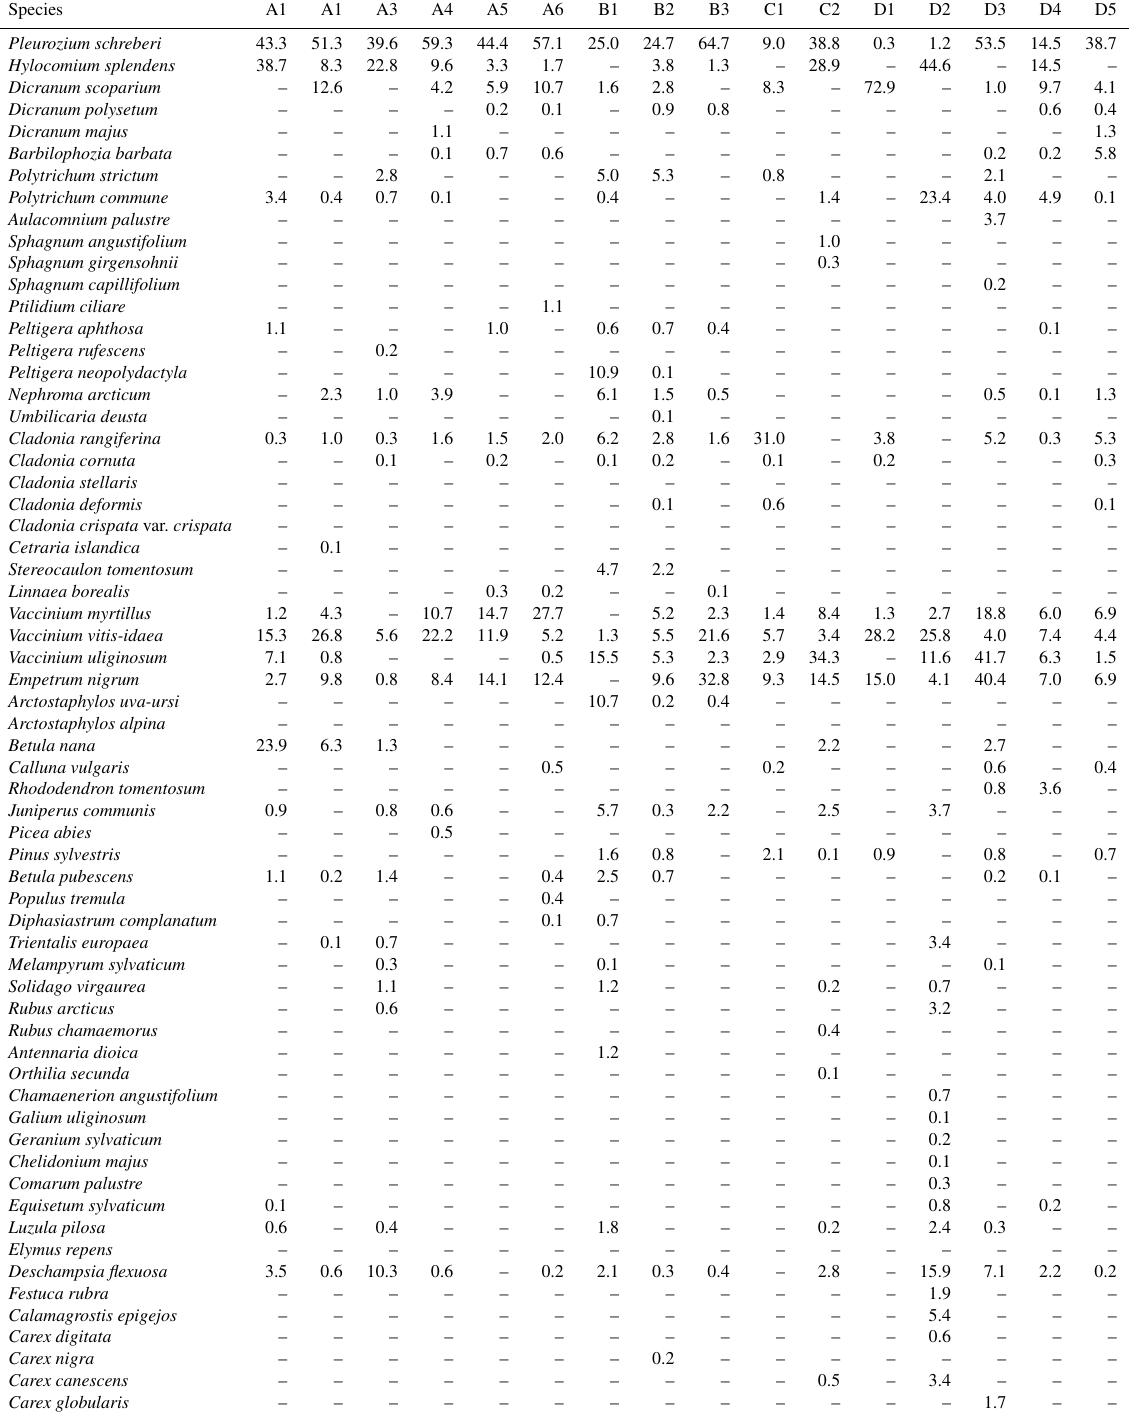
Table B1. Average coverage (percentage of surface area) of under- storey plant species per